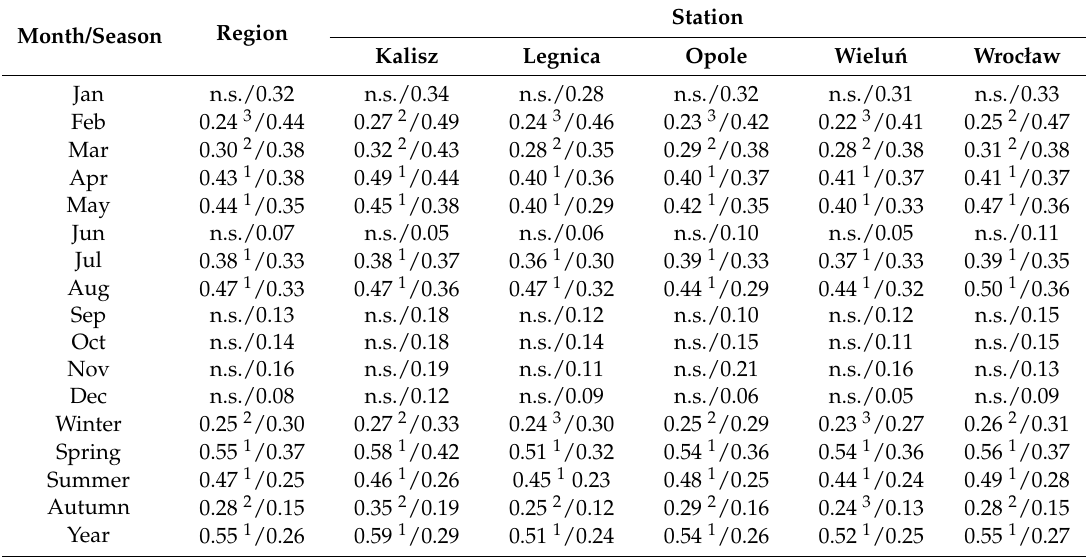
Table 5. Correlation coefficients for relationship between air temperature and the years 1951–2014, and the linear trend (in ◦ C/10